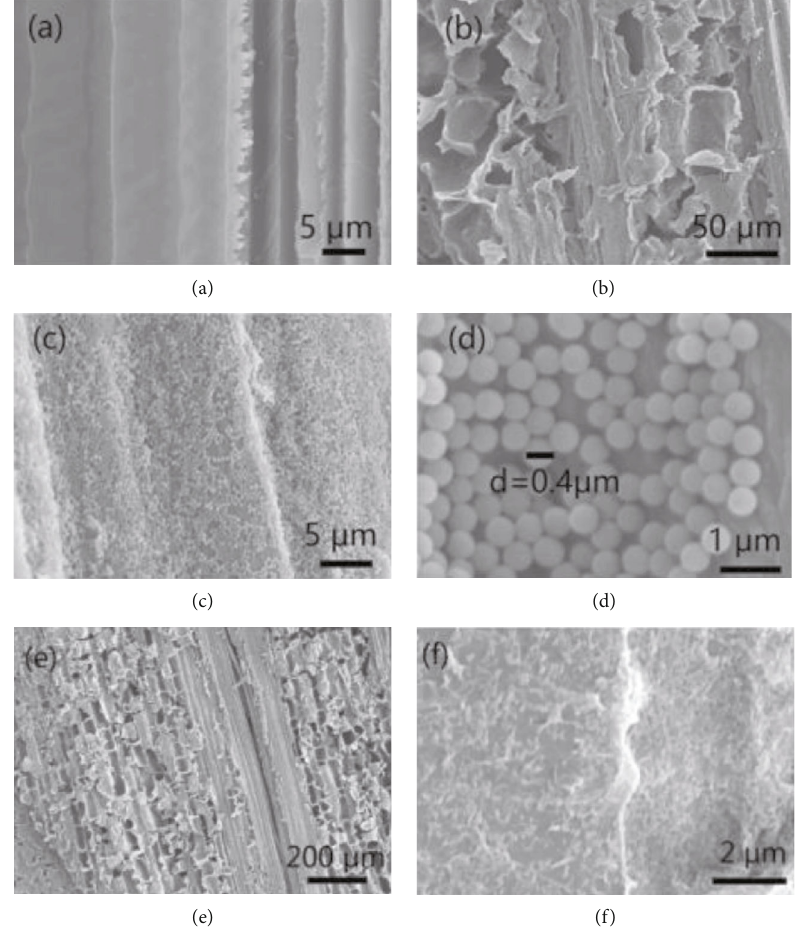
Figure 1: Typical low- and high-magni fi cation SEM images of BT (a), RGO@SiO